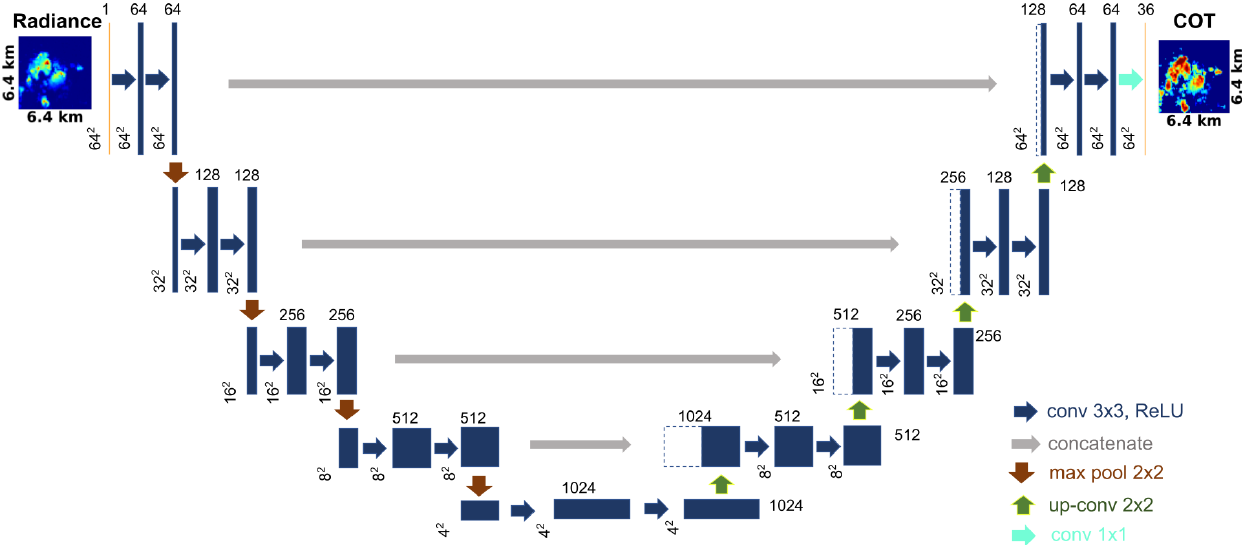
Figure 6. Architecture of the proposed model based on U-Net (Ronneberger et al., 2015). The radiance images of size 64 × 64 are fed through an input layer (shown in yellow on the left). The blue rectangular blocks depict convolutional layers. The number of filters for each convolutional layer is listed above each block (64, 128, 256,...). The blue arrows depict two sequential operations – the ReLU activation and batch normalization. Red arrows are max-pooling layers that downsample the previous layer by half. The gray arrows represent the concatenation operation whereby a source feature map from the contracting path (encoder) on the left is concatenated to a feature map from the expanding path (decoder) on the right (shown as dashed blue lines). The green arrows represent upsampling via bilinear interpolation and transposed convolution. The turquoise arrow is the final 2D convolutional layer that translates the previous layer to the requisite number of output COT bins, in this case 36. The yellow rectangle on the right is the final output layer that is activated by the softmax function to obtain 36 probabilities for each of the 36 COT